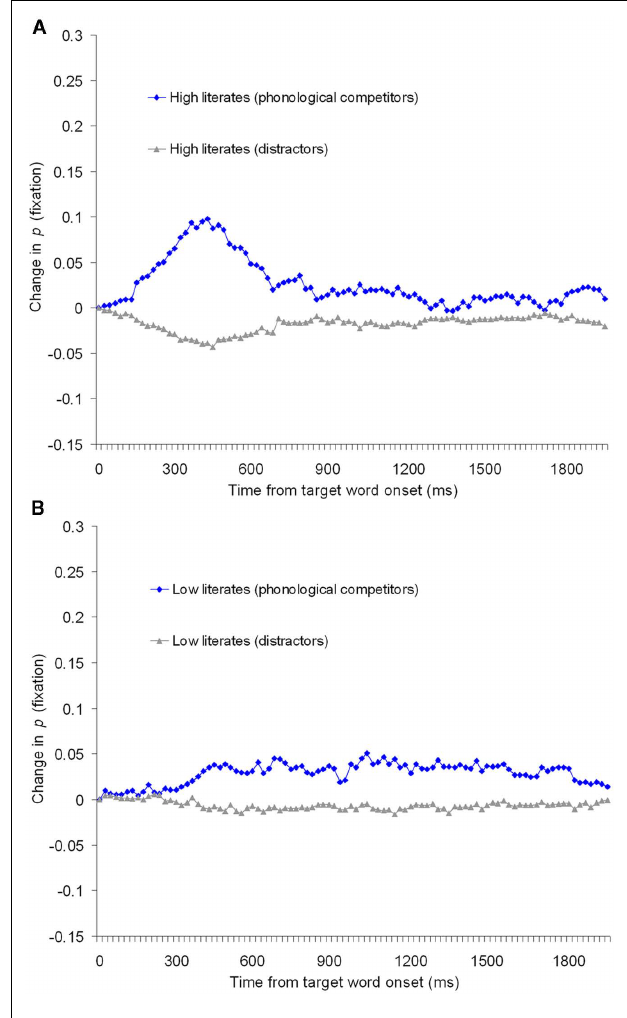
FIGURE 5 | Change in fixation proportions in Experiment 2 for (A) high literates and (B) low